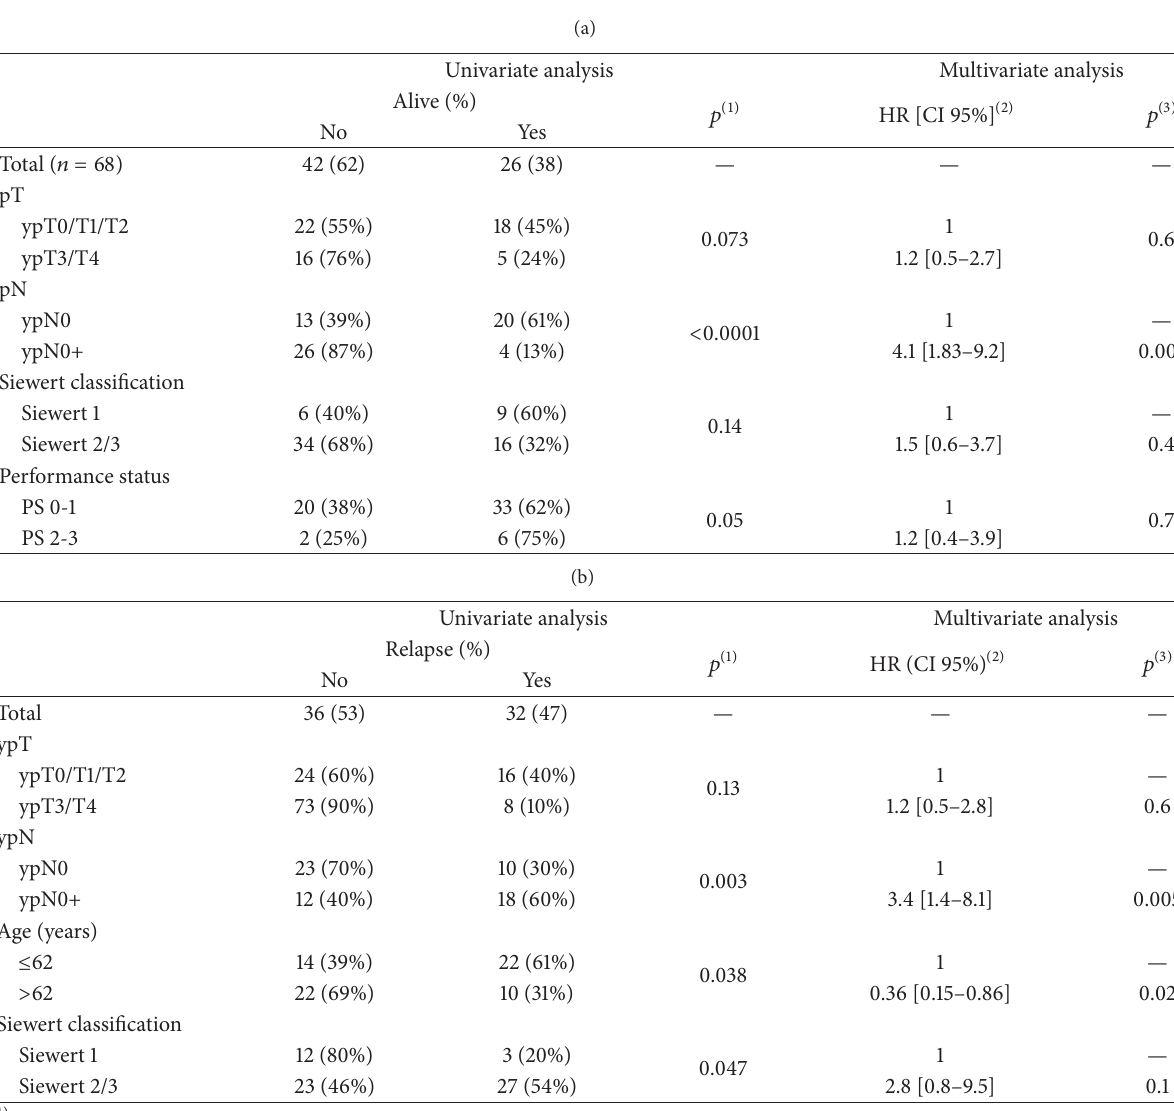
Table 4: Uni- and multivariate analysis for overall survival (a) and overall relapse rate